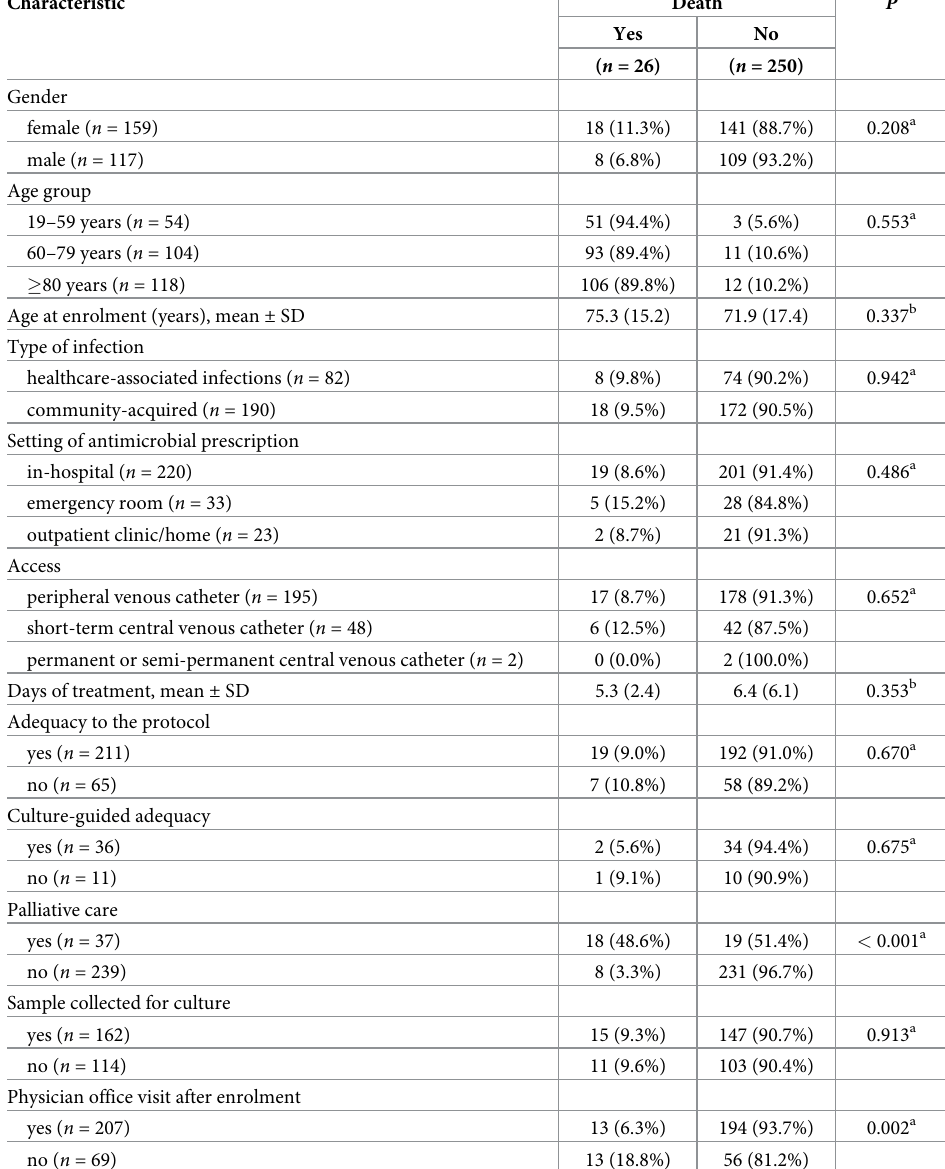
Table 3. Bivariate analysis of factors associated with mortality among patients enrolled in an outpatient paren- teral antimicrobial therapy program ( n = 276) at facilities within the Santa Helena/Amil UnitedHealth Group net- work, October 2016 through June 2017.